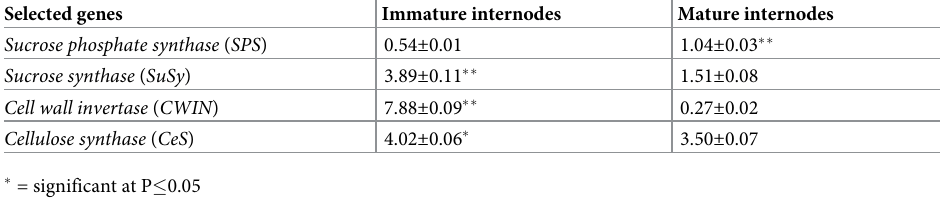
Table 7. Genes relative expression in immature and mature internodes of GXB9. Selected genes